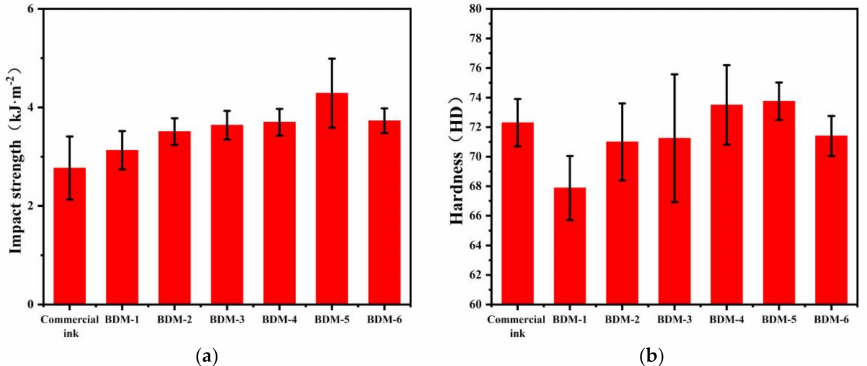
Figure 4. ( a ) Impact strength and ( b ) hardness of 3D-printed samples based on commercial ink and BDM inks.